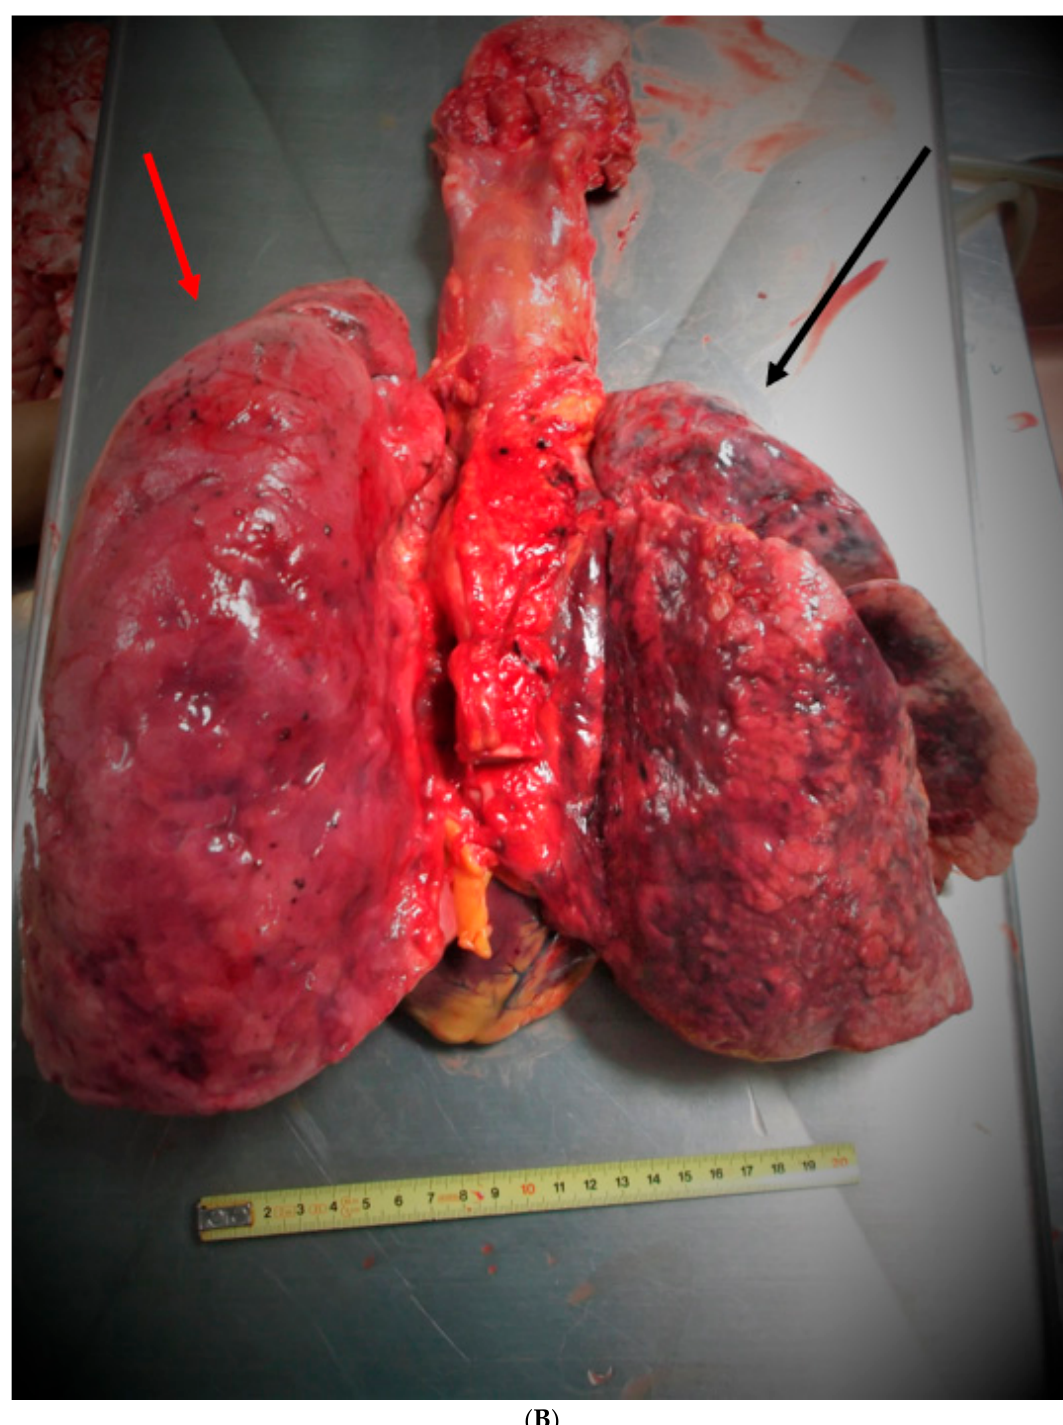
Figure 1. ( A ) Anterior view. Heart-lung block showing the right lung strongly retracted, with discolored and petechial hemorrhagic areas on the outer surface (black arrow). Left lung without evident macroscopic alterations (red arrow). ( B ) Posterior view. Heart-lung block showing the right lung strongly retracted, with discolored and petechial hemorrhagic areas on the outer surface (black arrow). The left lung does not present particular macroscopic alterations (red arrow).